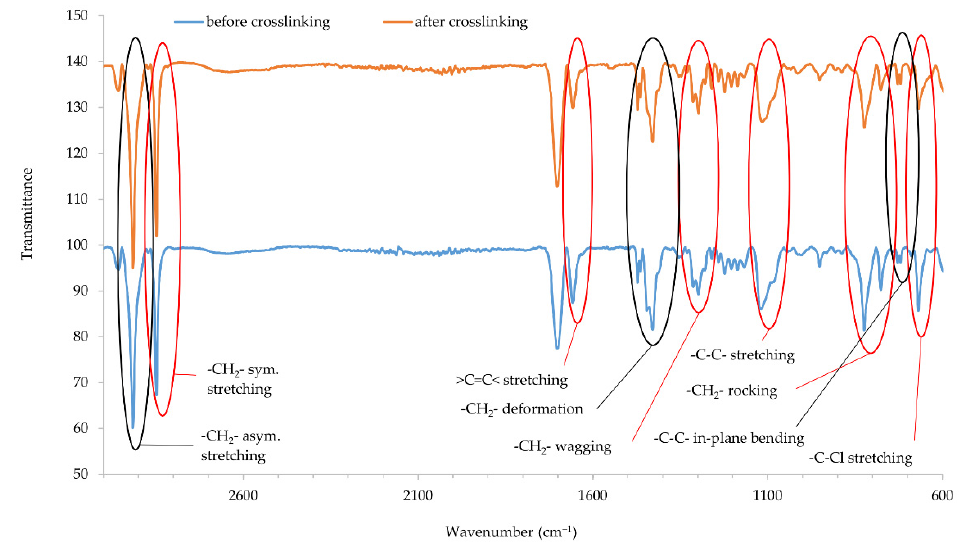
Figure 5. IR spectra of CR composition cross-linked with copper(I) oxide (3 phr of Cu 2 O); T = 160 °C, t = 45 min.